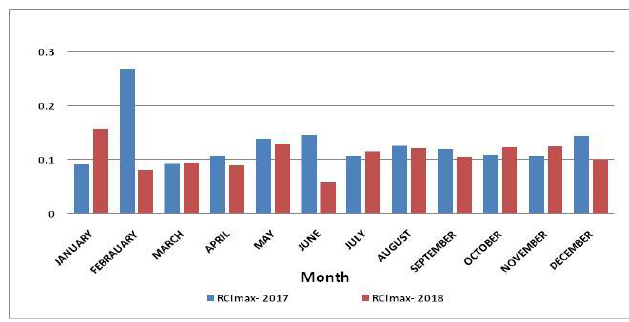
Figure 37. Comparison between RCI for maximum values of upward power ramps in 15 min interval for each month for years 2017 and 2018.